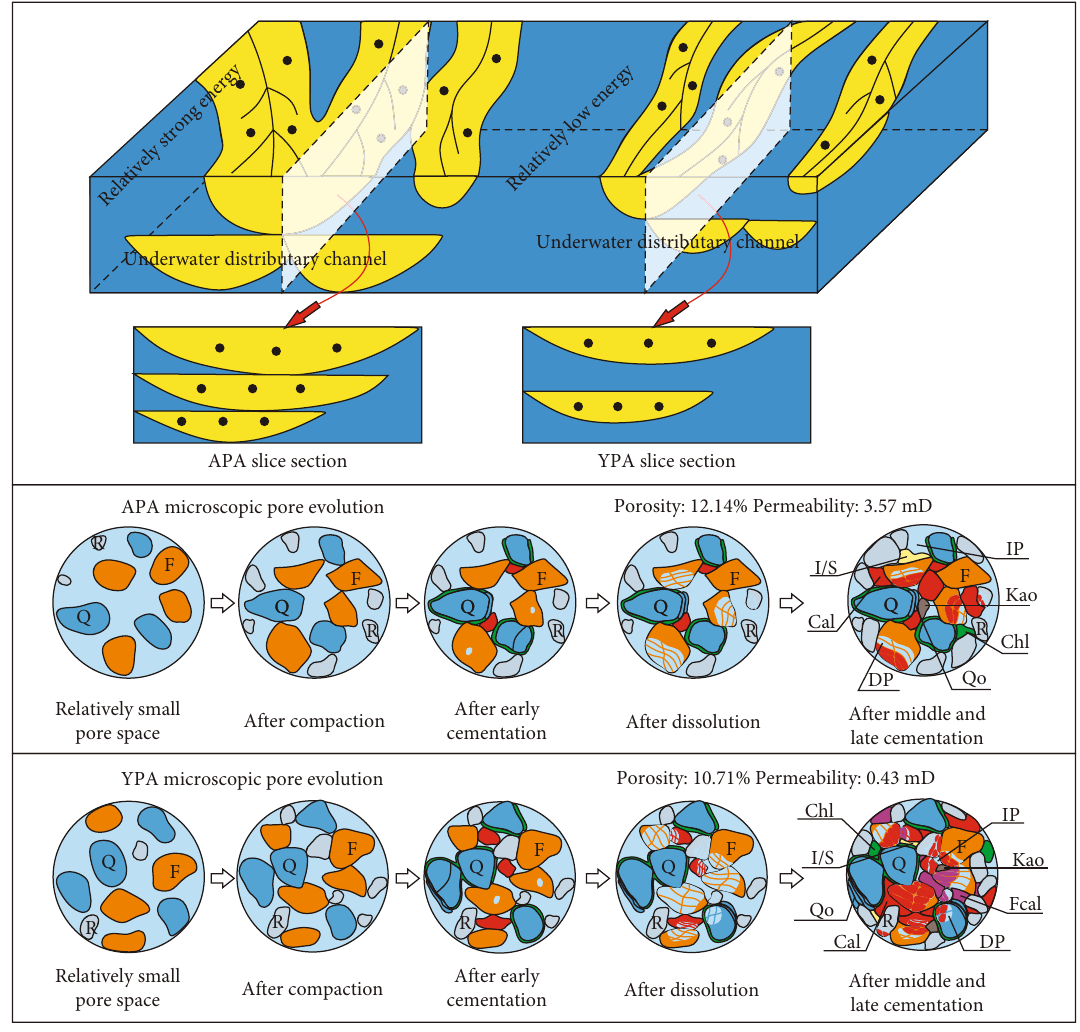
Figure 16: Comparison model of the di ff erences in the Chang 8 from